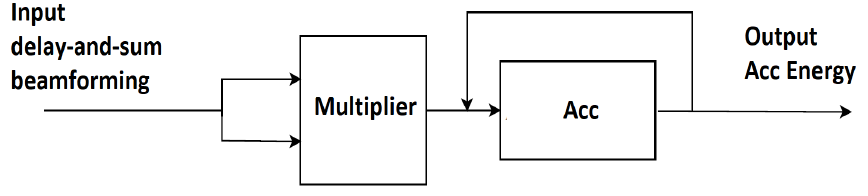
Figure 16. The method of realization and implementation for Equation (5).